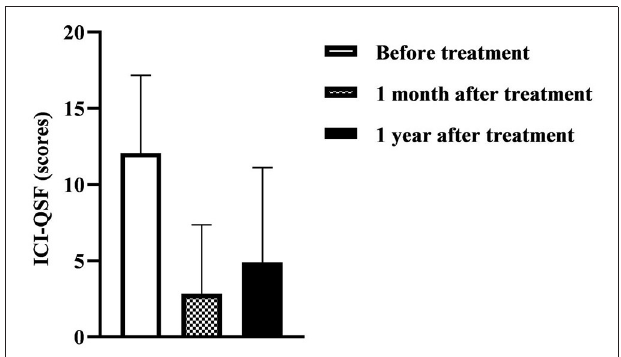
FIGURE 2 | The International Consultation on Incontinence Questionnaire-Urinary Incontinence Short Form (ICI-QSF) score at 1 month and 1 year after treatment with Modified Buzhong Yiqi Decoction ( n = 90).